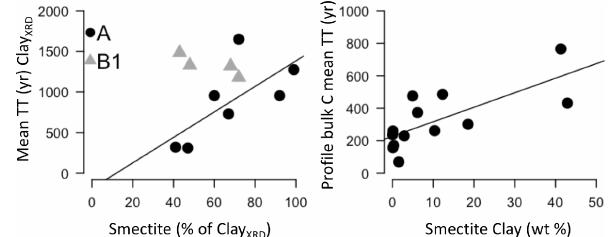
Figure 6. Across all the studied soils, the mean organic C con- tent (gCkg − 1 ) in the soil profile was best predicted by Fe(d)– Fe(o) (left; R-squared = 0.60, p = 0.003), and cation exchange ca- pacity corrected for organic matter content (C-corr CEC) (right; R-squared = 0.63, p = 0.0003). The best predictors for profile- averaged C turnover times was the amount of smectite clay (Fig. 5 (right)). Correlation matrices for other variables in Table 5 are given as Table